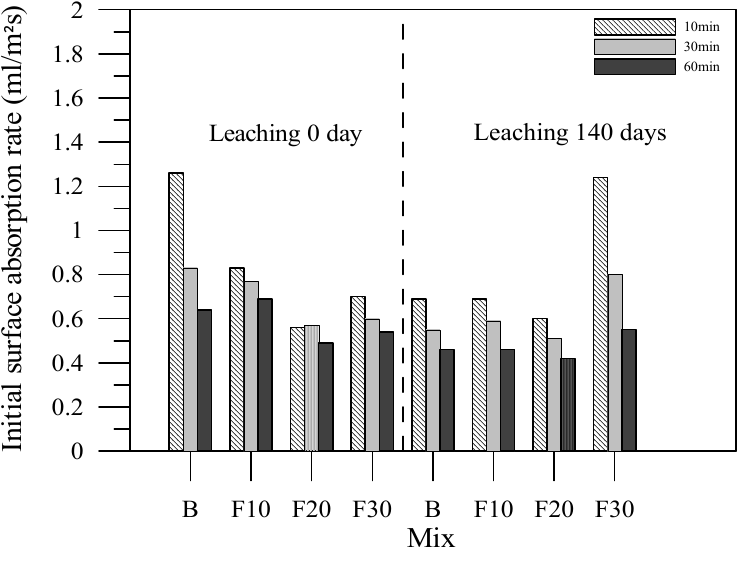
Figure 17. Initial surface absorptions of the specimens with fly ash